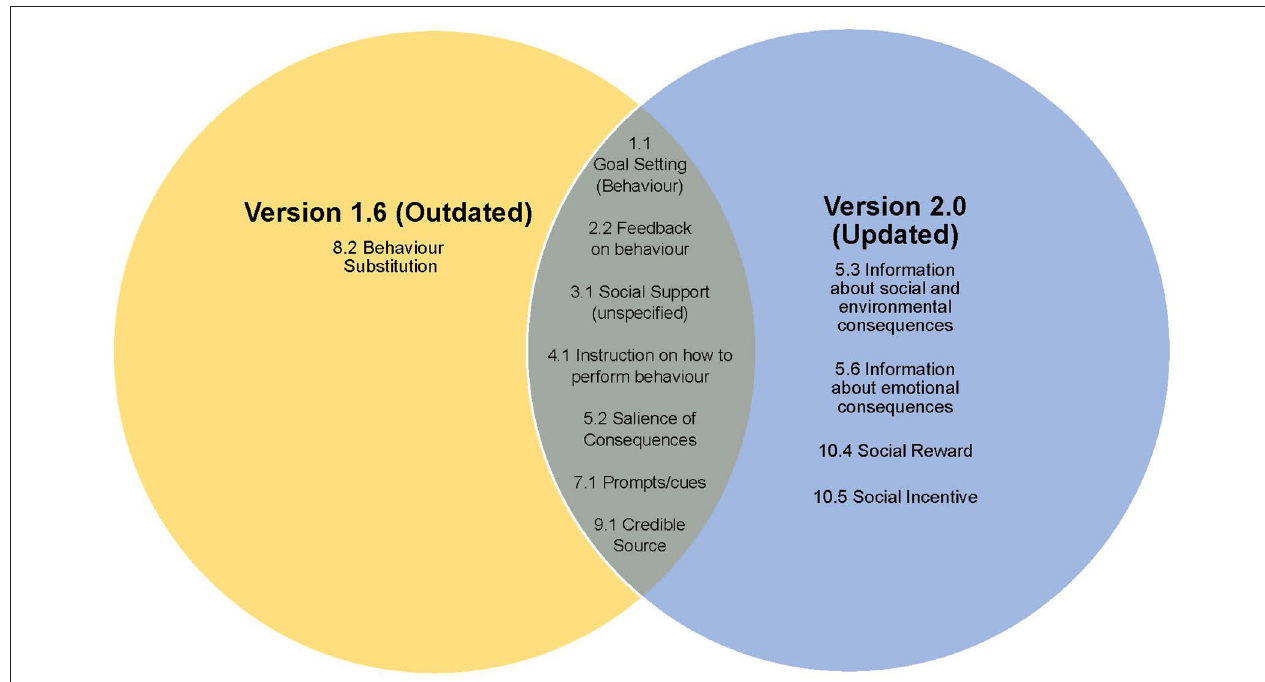
FIGURE 1 | Venn diagram displaying the BCT commonalities and differences between the outdated and updated versions of the Change4Life Food Scanner